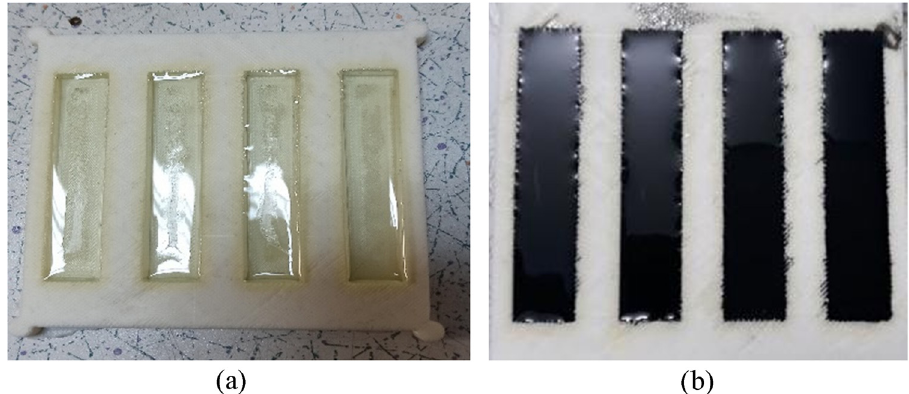
Figure 2: Pouring the samples into molds: ( a ) neat samples produced in the mold and ( b ) molded nanocomposite